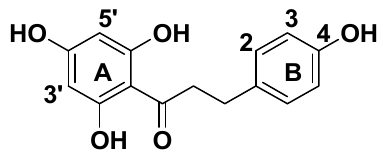
Figure 1. The structure of phloretin.